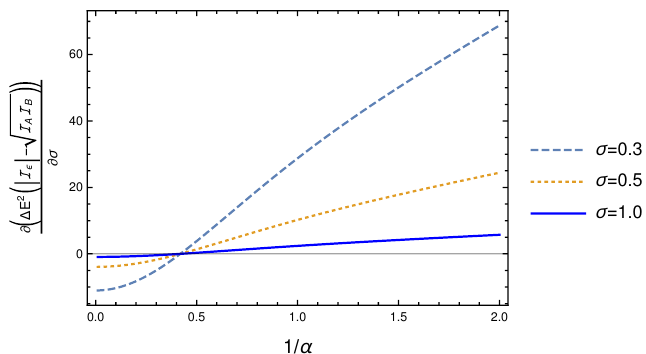
√ (cid:0) ∆ (cid:0) (cid:1)(cid:1) is plotted for two E 2 |I ε | − I A I B = 2 . 3854 . c